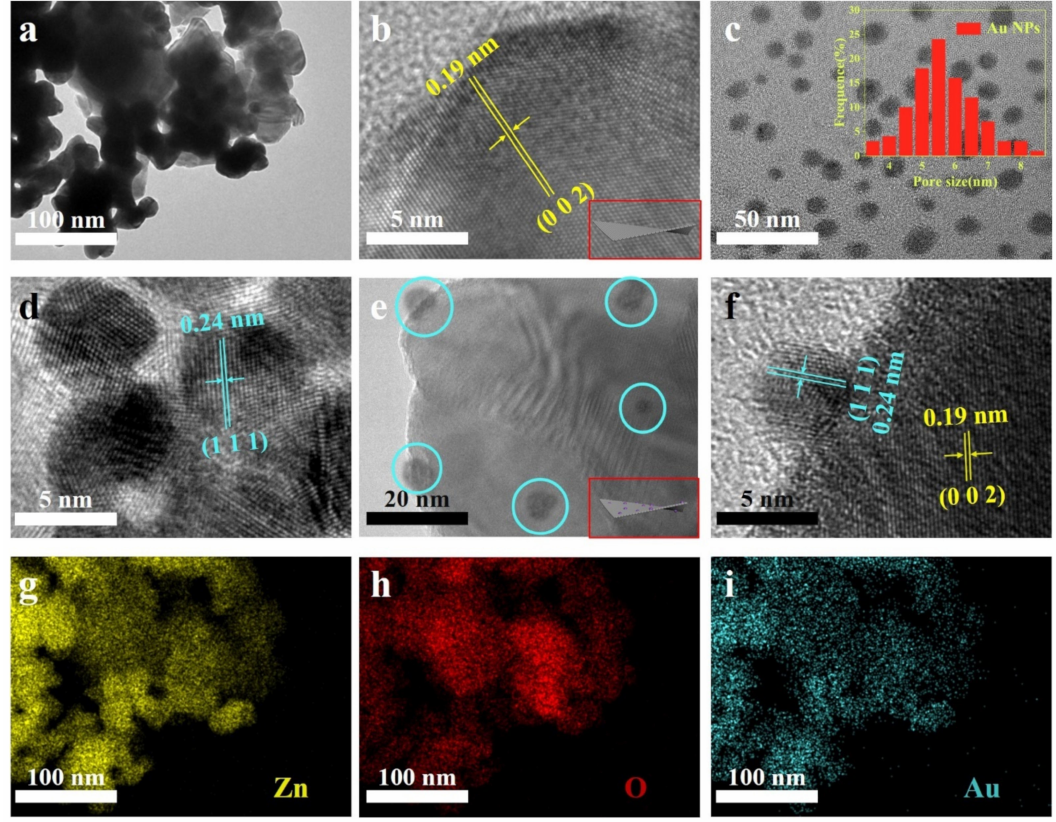
Figure 3. ( a ) TEM and ( b ) HRTEM images of pure ZnO NS. ( c ) TEM images and the particle size distribution of Au NPs. ( d ) HRTEM image of Au NPs. ( e ) TEM and ( f ) HRTEM images of 1.0% Au/ZnO NS. ( g – i ) STEM − EDS elemental mapping images of 1.0% Au/ZnO